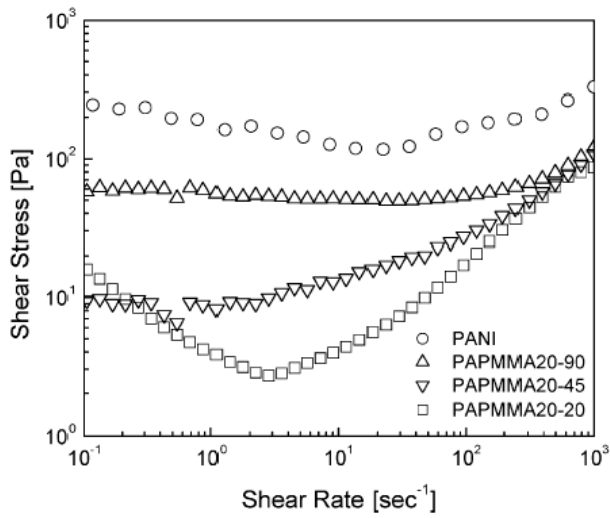
Figure 12. Shear stress as a function of the shear rate for pure PANI and core-shell structured PMMA/PANI with a core size of 2 µm (PAPMMA20-20), 4.5 µm (PAPMMA20-45), and 9 µm (PAPMMA20-90)-based ER fluids (10 vol % in silicone oil) at an electric field strength of 3 kV/mm. (Cho et al. [57], Copyright American Chemical Society, 2003).